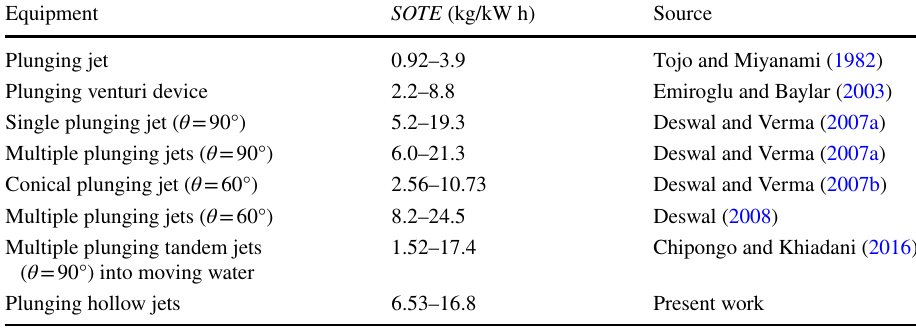
efficiency comparison with different aeration systems